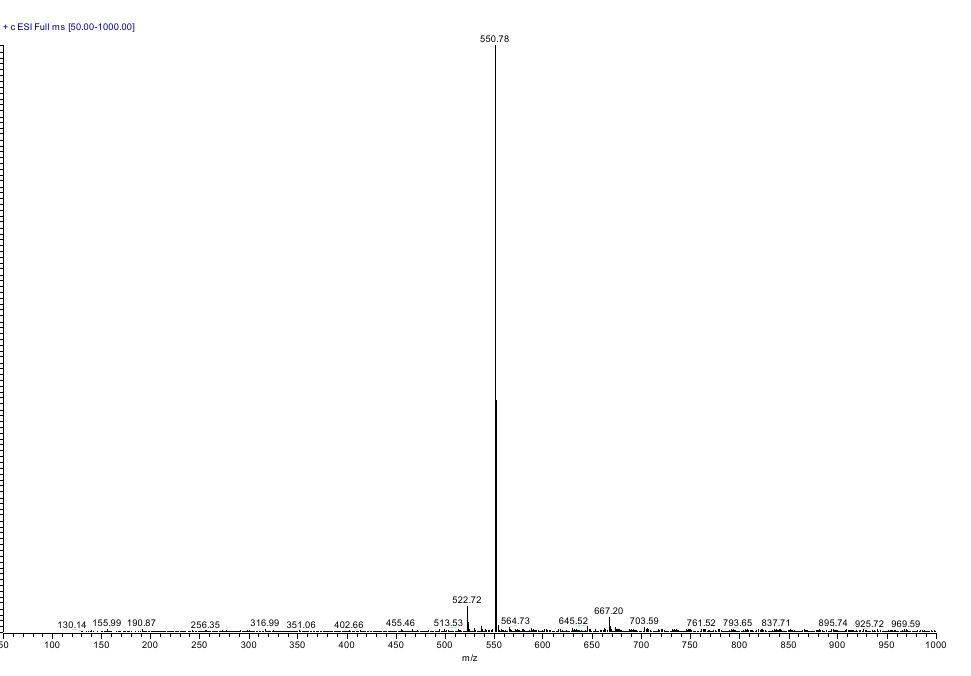
Figure 3. Low resolution mass spectrum acquired in positive ionization mode (ESI) of red beetroot lyophilized extract with peaks at 550.78 (100.00 %) and 551.78 m/z (39.50%).